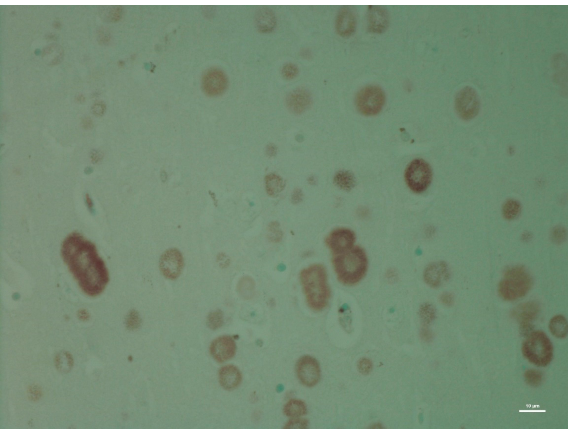
Figure 2. Periodic acid-Schiff (PAS)-stained section of the hippocampus region of the brain of the same moose showing round polyglucosan (Lafora) bodies.